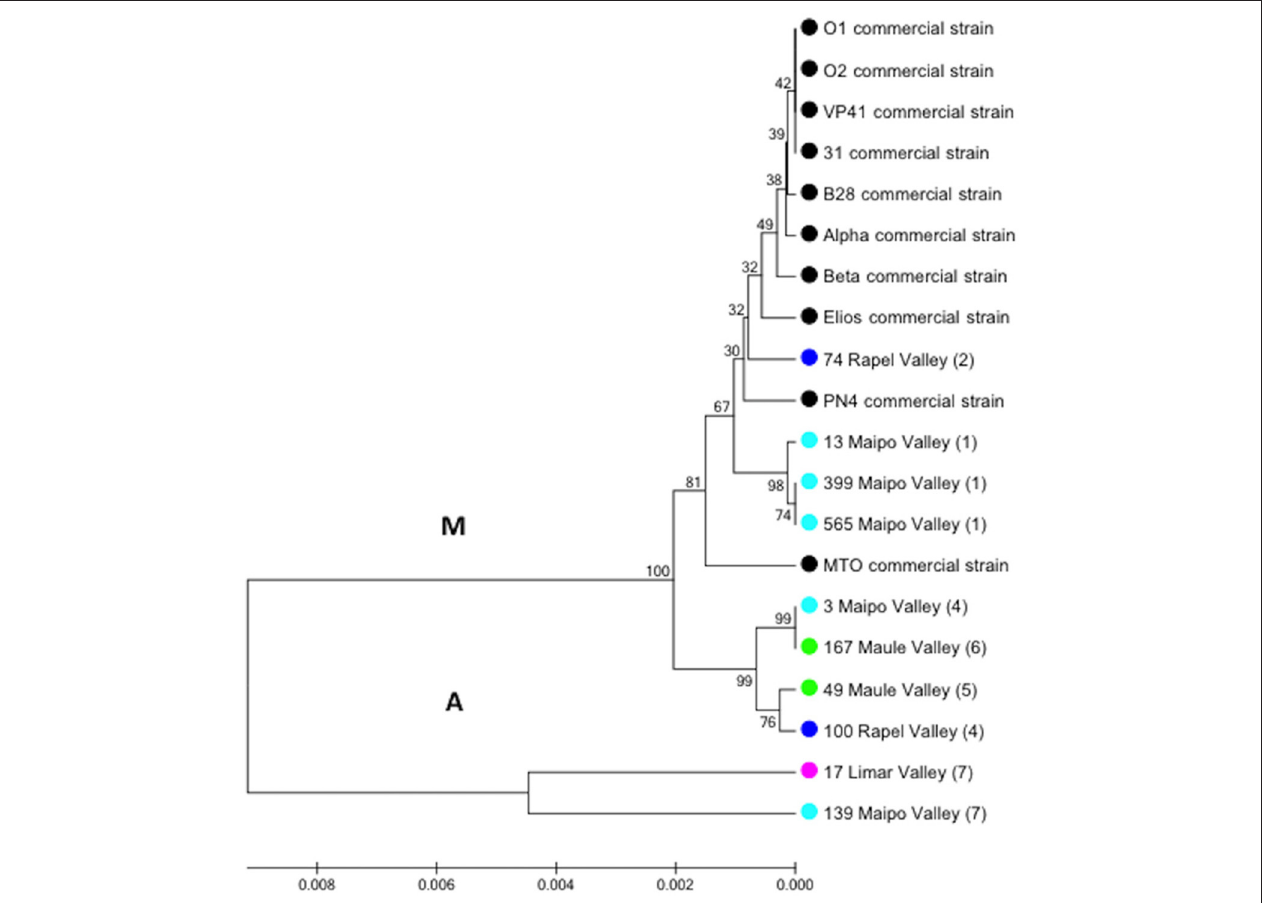
FIGURE 2 | Phylogenetic reconstruction based on the seven gene markers MLST scheme. Analysis included O. oeni commercial strains and Chilean autochthonous O. oeni isolates, which were distributed in two genetic groups indicated as M and A. Colored circles indicate the origin of each isolate (Chilean valley or commercial). Numbers correspond to signature group described in Table 2